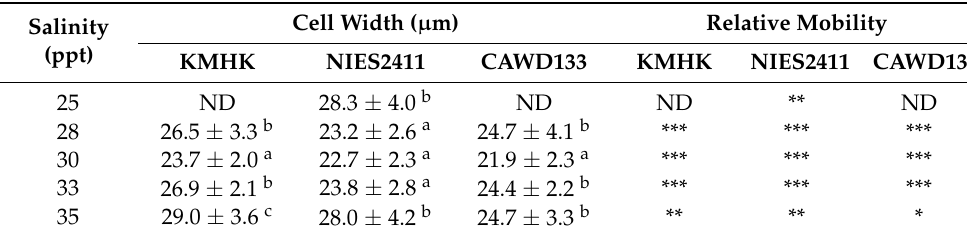
Table 2. Variations in cell width and mobility of the three K. mikimotoi strains (KMHK, NIES2411 and CAWD133) growing in different salinities. The mean ± standard error of mean (SEM) of 30 replicates are shown. Small letters represent significant differences of cell width of a K. mikimotoi strain at different salinities. The number of stars indicate relative mobility (*, **, ***). ND: not determined due to lysis of algal